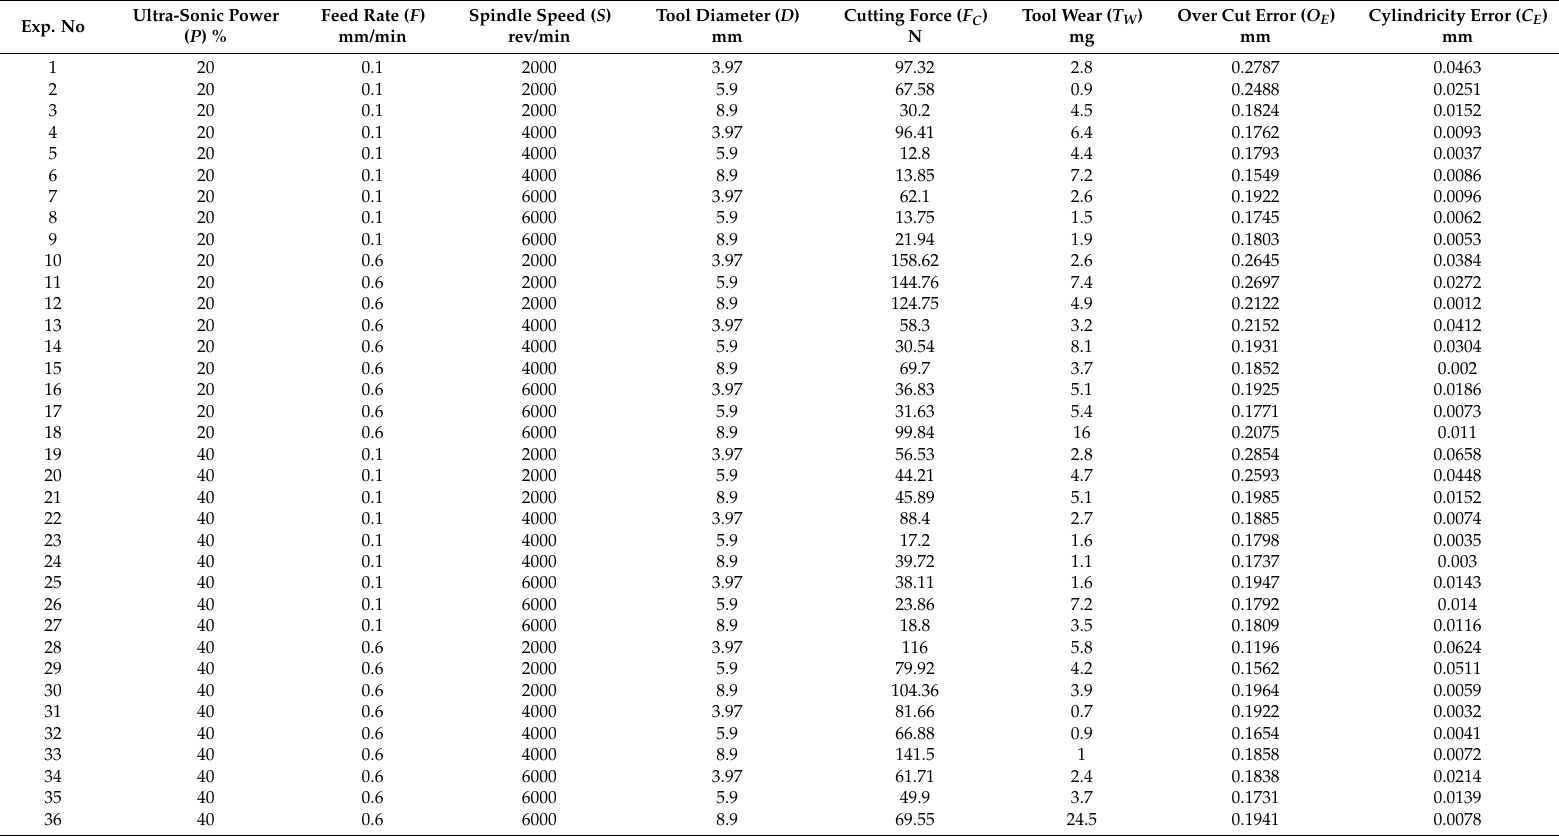
Table 4. Design of experiments and corresponding